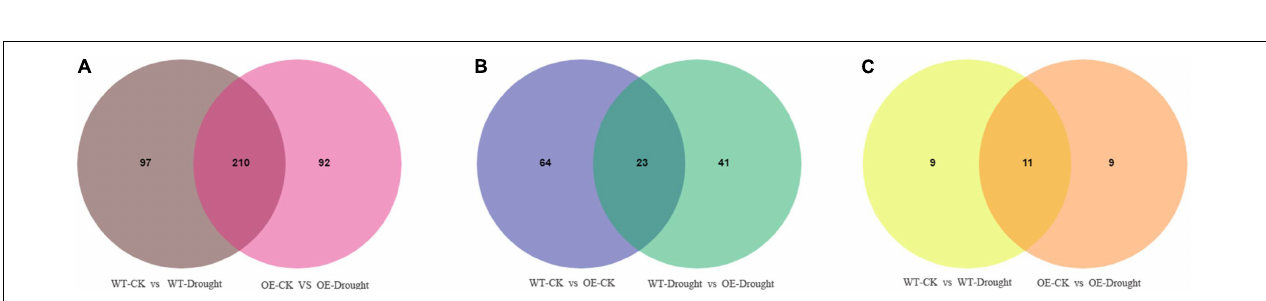
FIGURE 8 | Qualitative and quantitative analyses of differentially expressed metabolites in OE plants after drought stress. (A) PCA score plots for the mass spectra data of WT and OE samples. The abscissa represents the first principal component (PC1), while the ordinate represents the second principal component (PC2). (B) Volcano plot of differentially expressed metabolites between WT and OE plants. The abscissa represents the contents of differentially expressed metabolites between the two samples; a greater absolute value of the abscissa indicates a greater difference in relative content. A larger ordinate value indicates a more credible difference. Red scatter indicates metabolites that were significantly upregulated; green scatter indicates metabolites that were significantly downregulated; gray scatter indicates metabolites with no significant difference. (C) Clustering analysis of the metabolome data from WT and OE plants. Heatmap representation of the levels of differentially expressed metabolites and the color indicated low (green) to high (red). Each line in the heatmap represents a metabolite. Ten classes were evident after the clustering analysis. (D) The top 10 upregulated and downregulated metabolites between WT and OE plants. Red dots represent upregulated metabolites; green dots represent downregulated metabolites. (E) KEGG enrichment analysis of differentially accumulating metabolites between WT and OE samples. DA score represents the overall changes in all metabolites in the metabolic pathways; a score of 1 indicates upregulated trend, while a score of –1 indicates a downregulated trend. Each bubble in the plot represents the number of associated metabolites; P- values are indicated by colors.